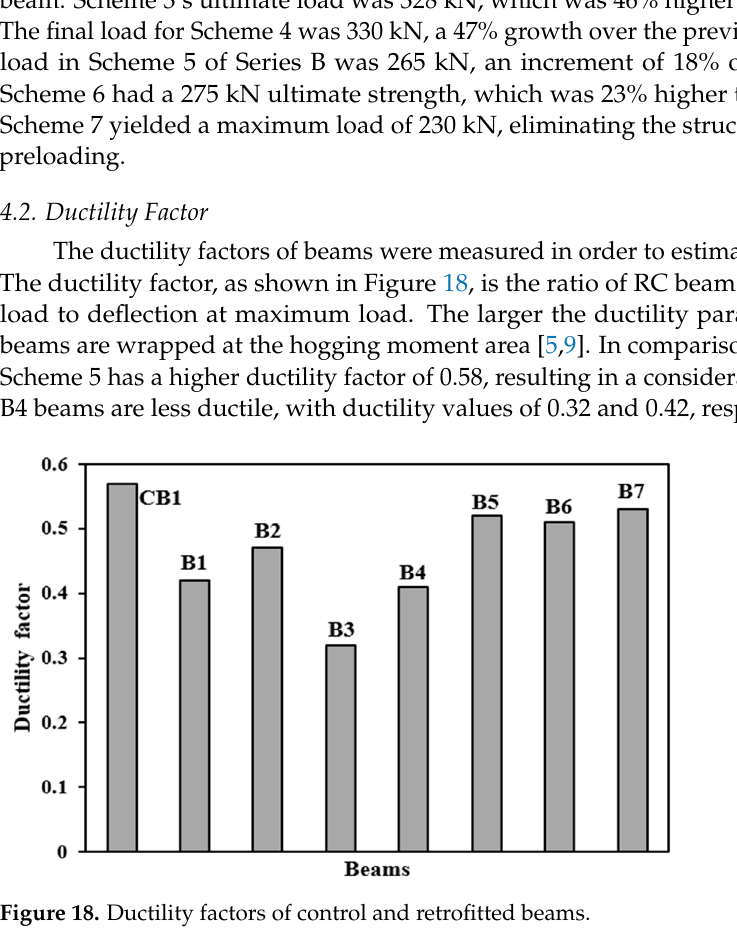
Figure 19. Stress–strain behavior of controlled and strengthened beams. 4.4. Modes of Failures and Crack Patterns 4.4.1. Different Types of Failures The visual inspection was used to identify the failure modes of modified beams. Flex- ural failure induced by CFRP sheet debonding, steel rupture, and CFRP rupture were all identified [20,37]. On the beams in Series A, flexural failures with steel and CFRP ruptures were reported. The tension face flexural cracks were identified beneath the load areas. As the load increased, the bending cracks started to expand vertically upward, as seen in Figure 20a,b. These cracks were not widened because U-shaped CFRP sheets were pro- vided. The B1 and B2 beams failed as a result of the steel rupture, while the CFRP sheets